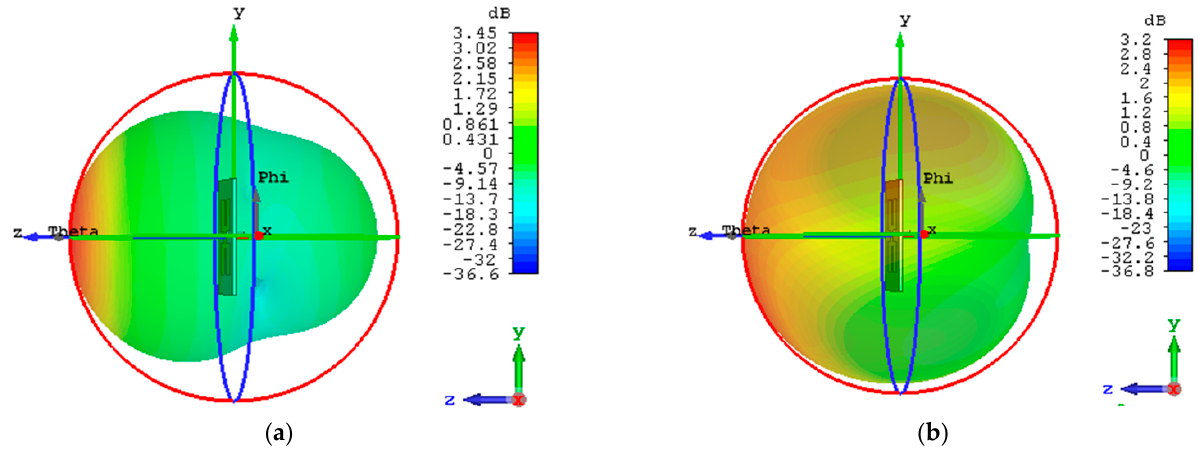
Figure 13. 3D radiation patterns of the dual-band slotted square patch antenna at ( a ) 2.4 GHz and ( b ) 2.8 GHz.